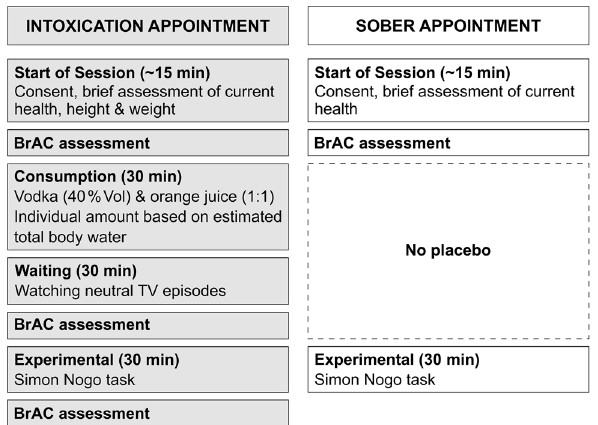
Figure 5. Illustration of the time course of both study appointments. The order of the appointments was randomized and there was a mandatory delay of no less than 2, and no more than 5 days between the appointments.